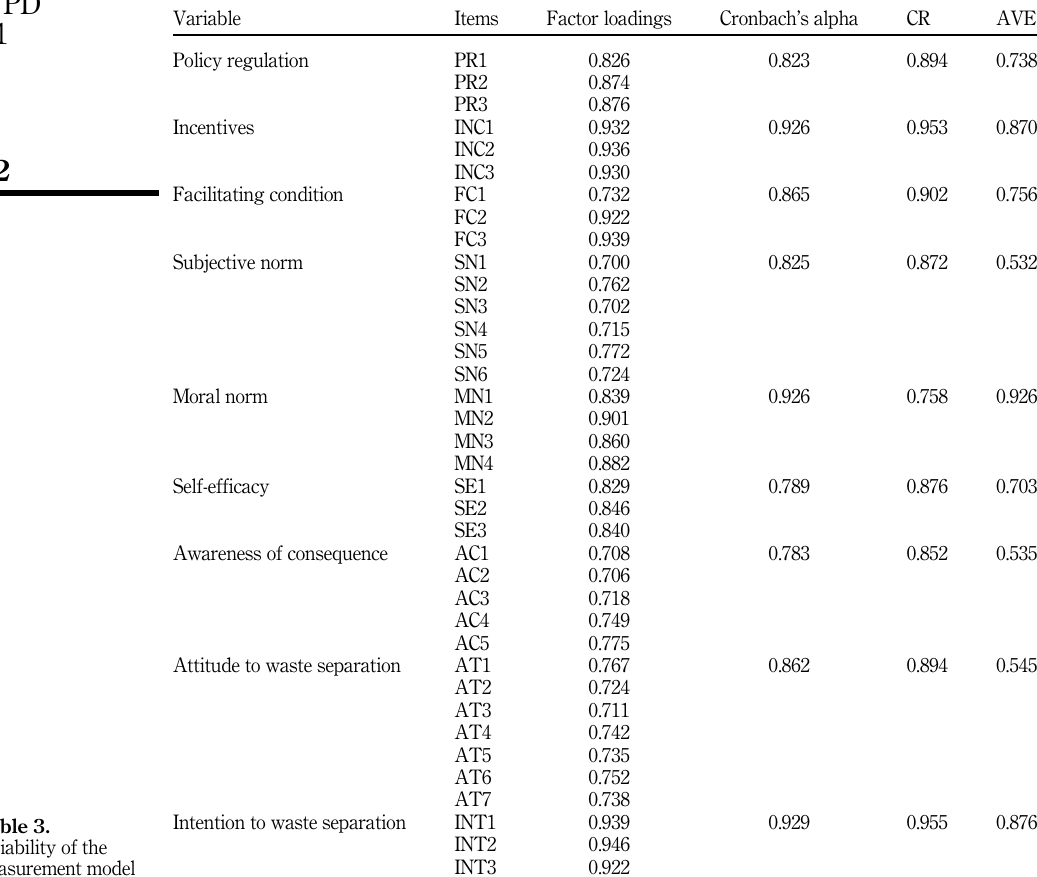
Table 3. Reliability of the measurement